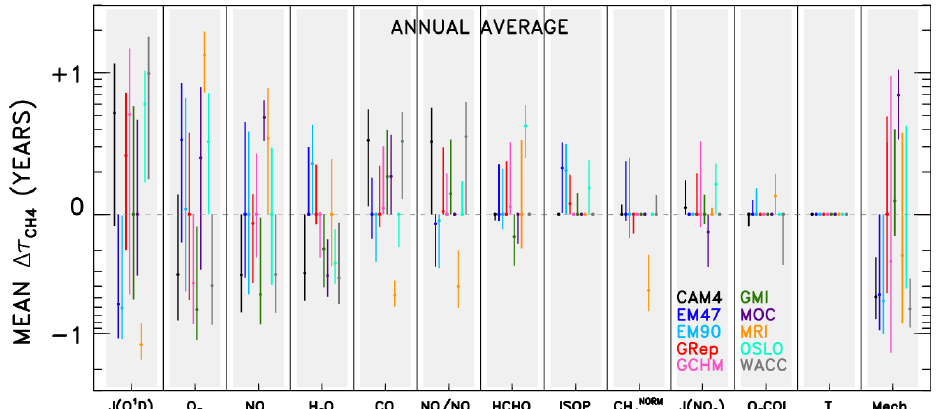
Figure 5. Averaged changes in CH 4 lifetime accrued for a specified model (colour), across all swaps of the indicated variable ( x axis) from all other models. Results are shown annually averaged for the year 2000 of the specified dynamics REF-C1SD CCMI and chemical transport model simulations. Circles indicate the mean change in CH 4 lifetime; bars represent the 1 σ standard deviation from all model pairings. Variables along the x axis are ranked by averaged magnitude of the (cid:49)τ CH values (i.e. inputs located farther left are responsible for larger 4 differences in CH 4 lifetime), except for the “Mech. + Nonlin.” term, which is shown last to indicate its role as a remainder term.